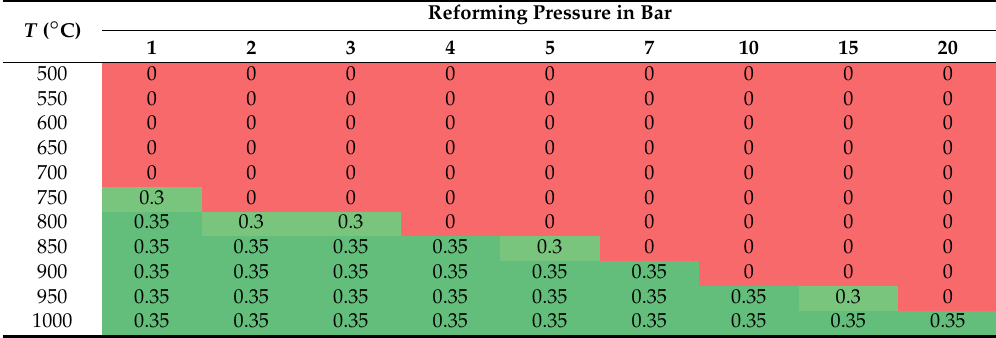
Green indicates a maximum CO 2 /CH 4 > 0, red indicates no CO 2